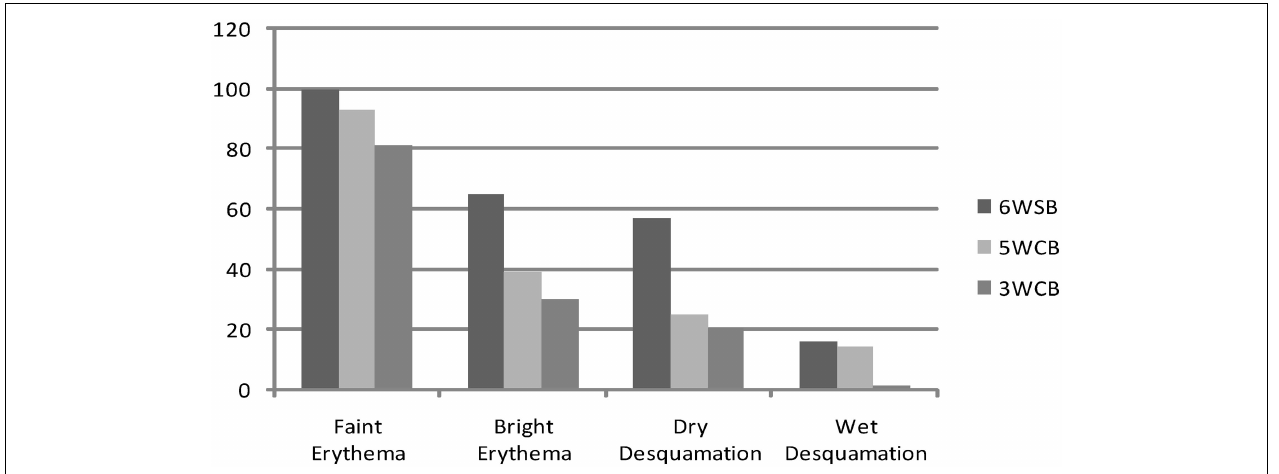
FIGURE 2 |Acute toxicities: maximum incidence of erythema and desquamation between the three regimens: 6wSB (6-week sequential boost), 5wC (5-week concomitant boost), and 3wCB (3-week concomitant boost).